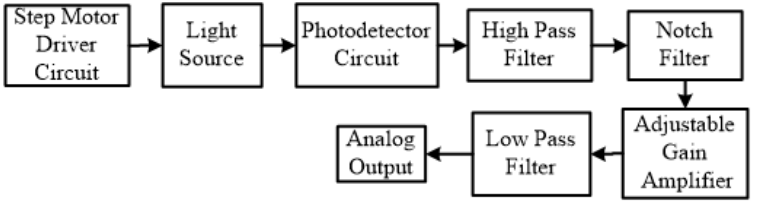
Fig. 4. The self-designed optical measurement system block diagram.